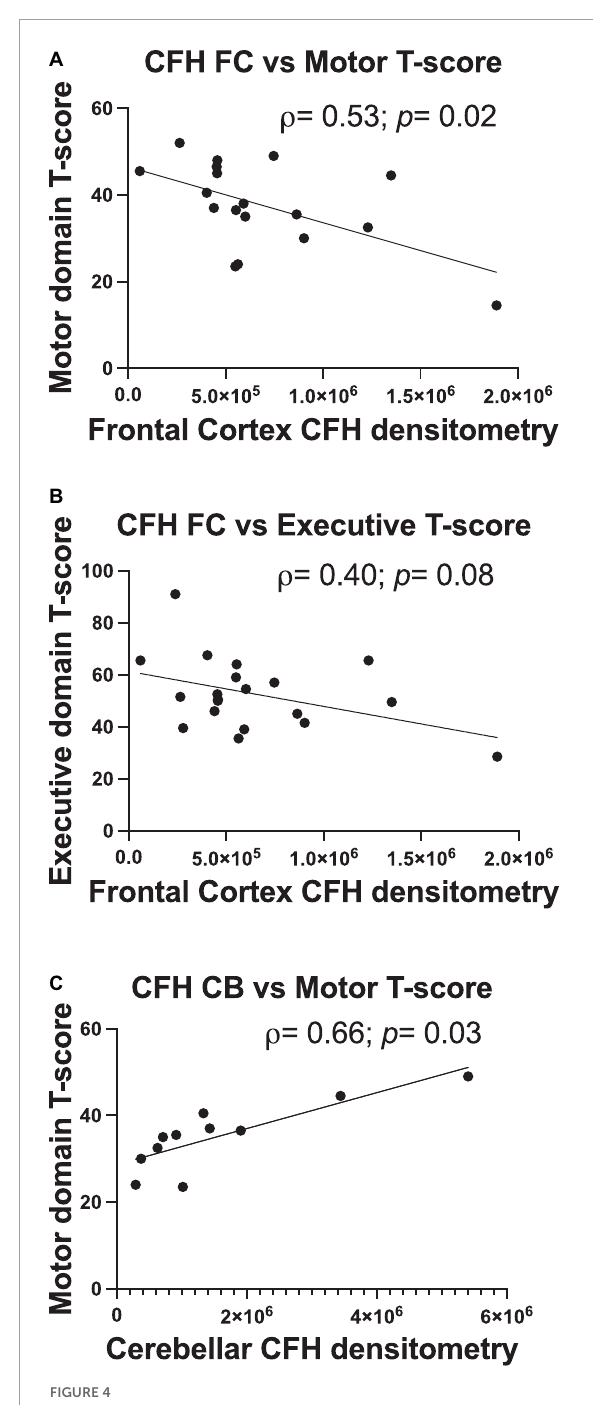
FIGURE4 Frontal and cerebellar CFH protein levels relate to antemortem performance in specific cognitive domains. Quantification of frontal cortex CFH band intensity relates to motor domain (A) and executive function domain performance (B) . Quantification of cerebellum CFH band intensity relates to motor domain performance (C) . Statistical significance was determined by a Spearman’s rank-order correlation ( ρ = Spearman’s rank correlation